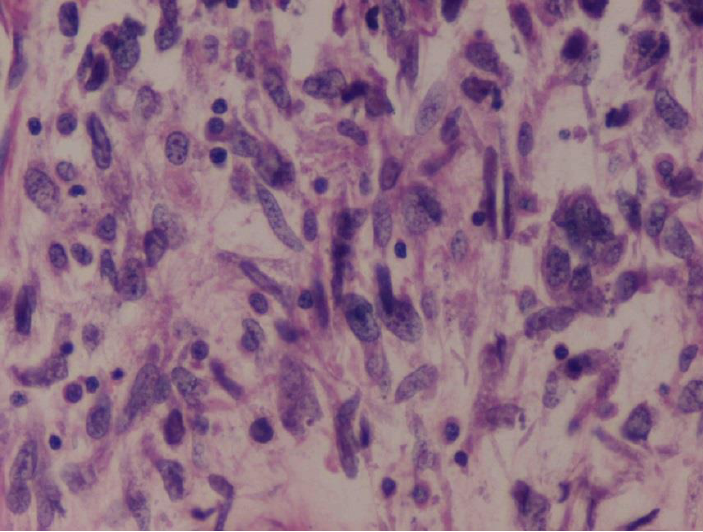
Figure 2. MTSCC: Foci of sarcomatoid differentiation were seen with pleomorphic high-grade nuclei without any evidence of vascular invasion. Haematoxylin and eosin,